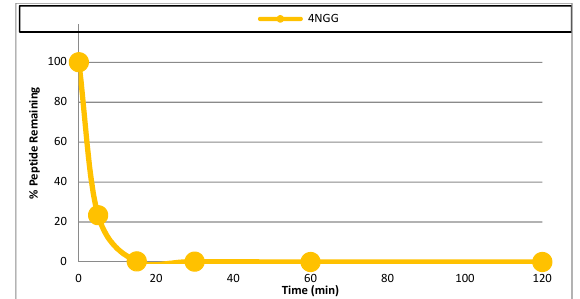
Figure 25. Serum activity evaluated with the 4NGG peptide degraded in 15 min.